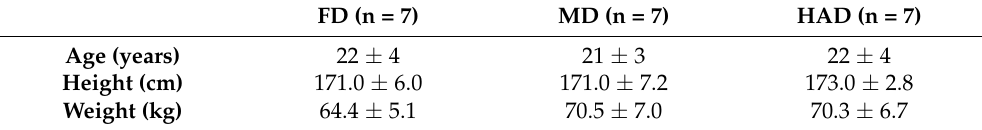
Table 1. Characteristics of female handball players (mean and standard deviation).